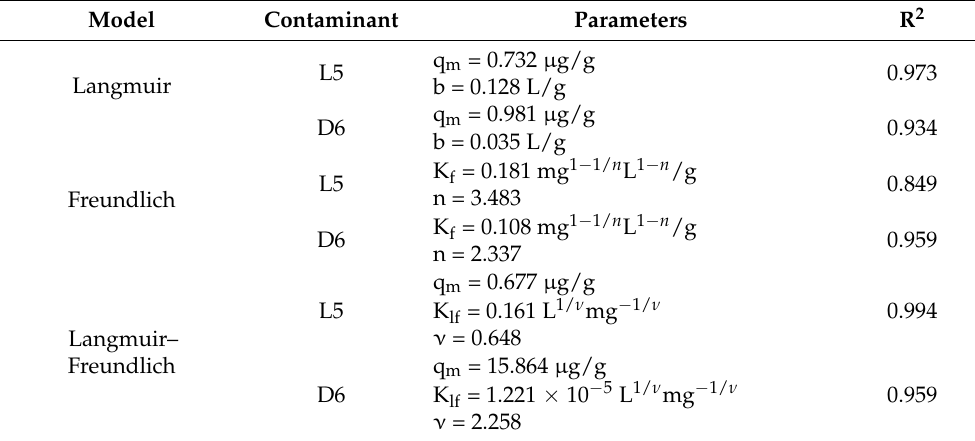
Table 1. Langmuir, Freundlich and Langmuir–Freundlich isotherm parameters and correlation coefficients for the adsorption of L5 and D6 in MSW at 298 K. Model Contaminant Parameters R